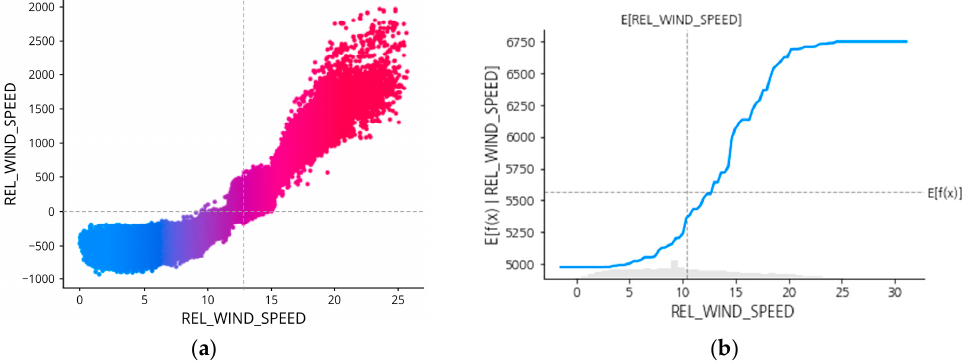
Figure 11. SHAP dependence plot ( a ) and partial dependence plot ( b ) of REL_WIND_SPEED.